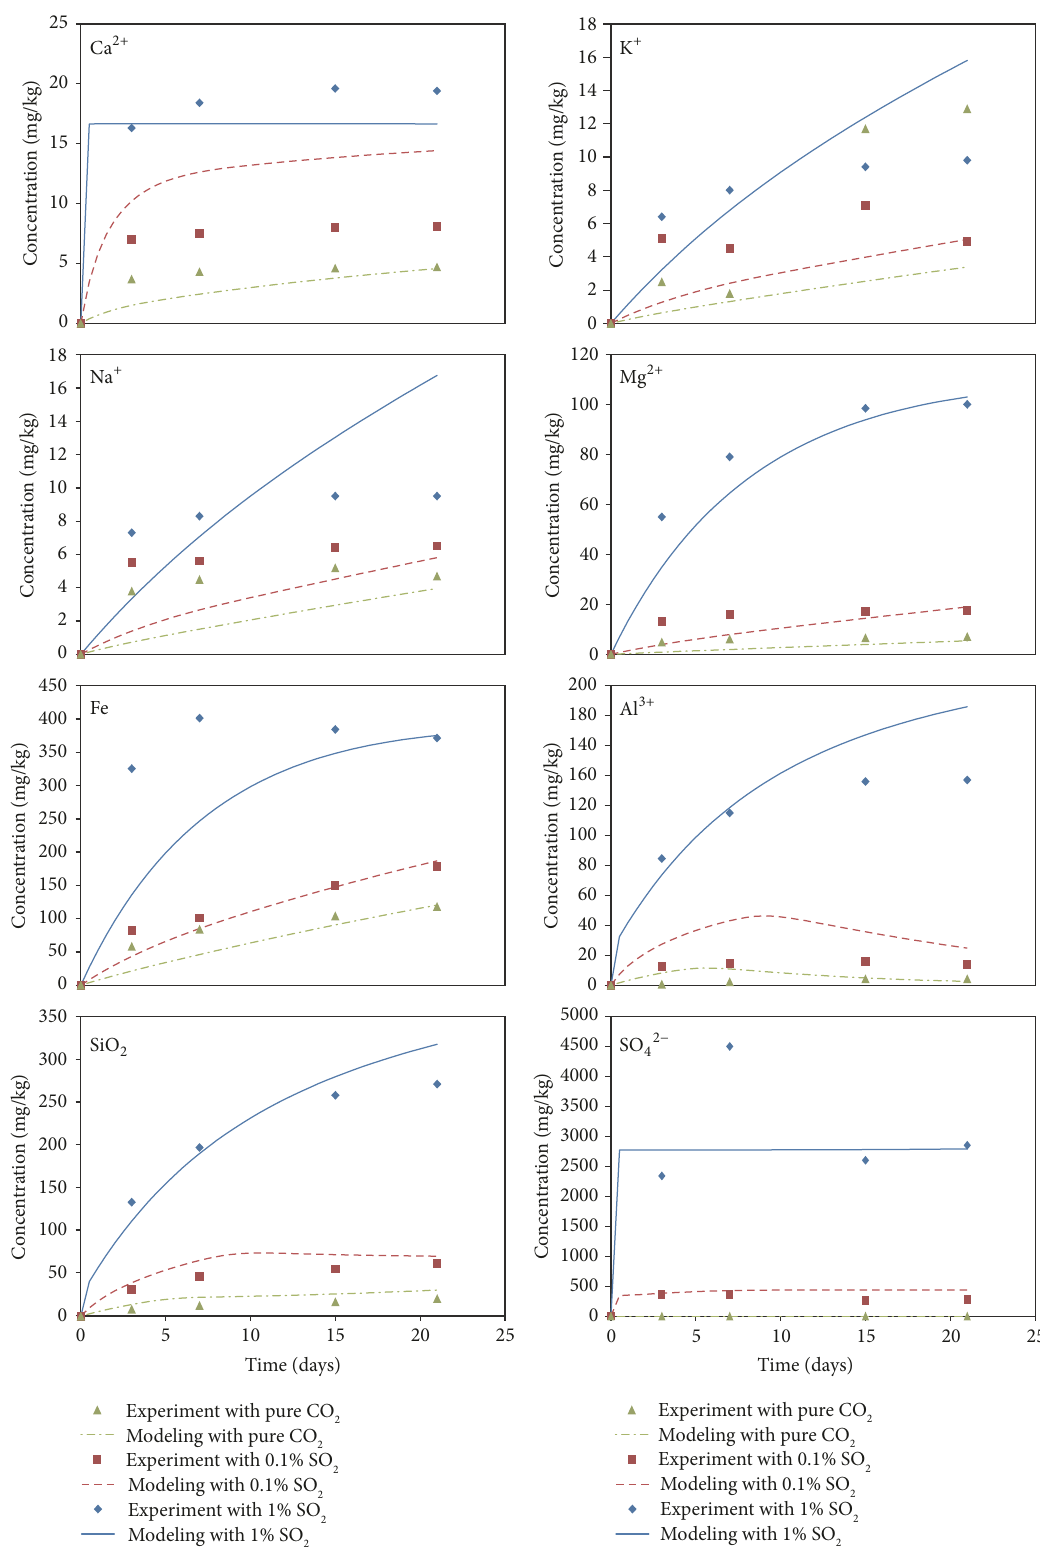
Figure 3: Changes in the concentration of cations during gas-water-rock experiments (green triangle = pure CO 2 case, red square = 0.1% SO 2 case, and blue rhombus = 1% SO 2 case) and changes in the concentration of cations in the modeling (green dashed line = pure CO 2 case, red dashed line = 0.1% SO 2 case, and blue solid line = 1% SO 2